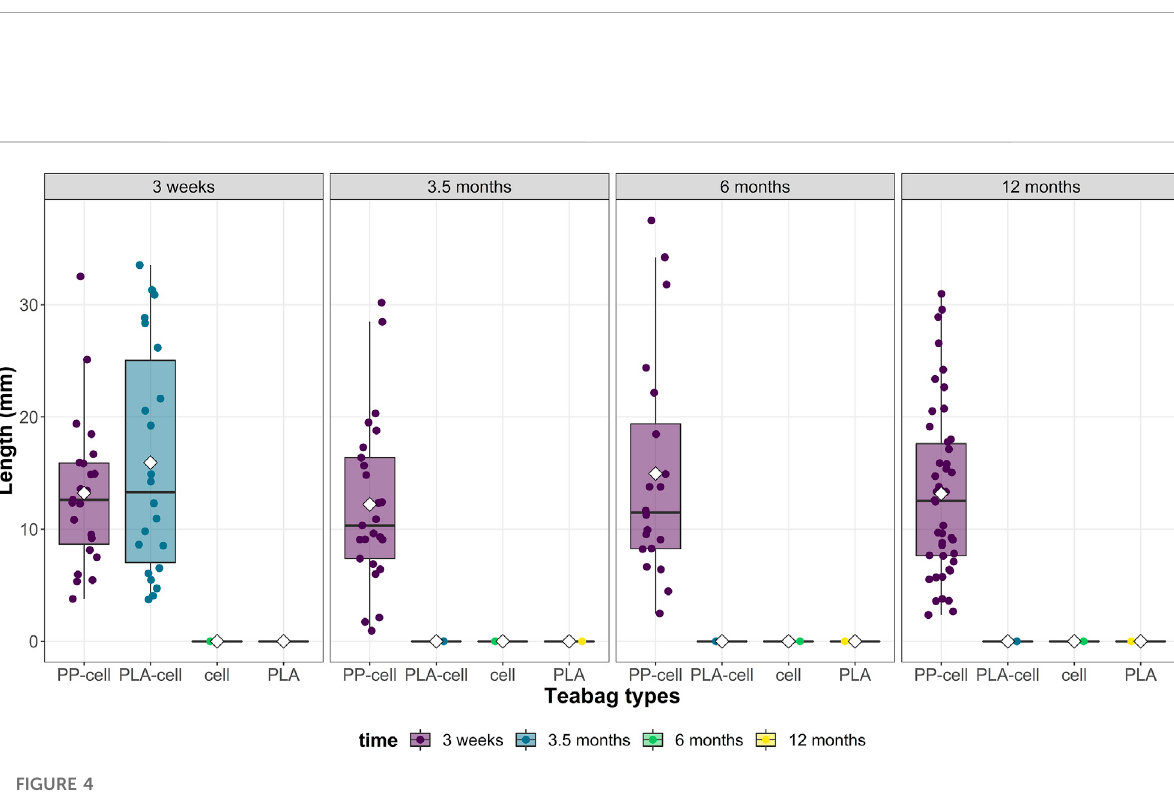
FIGURE 3 Teabag fragments (left) and degraded teabags (right) from teabags made of PLA-cellulose after 3 weeks in soil (A,B) and PP-cellulose after 3.5 months in soil (C,D)